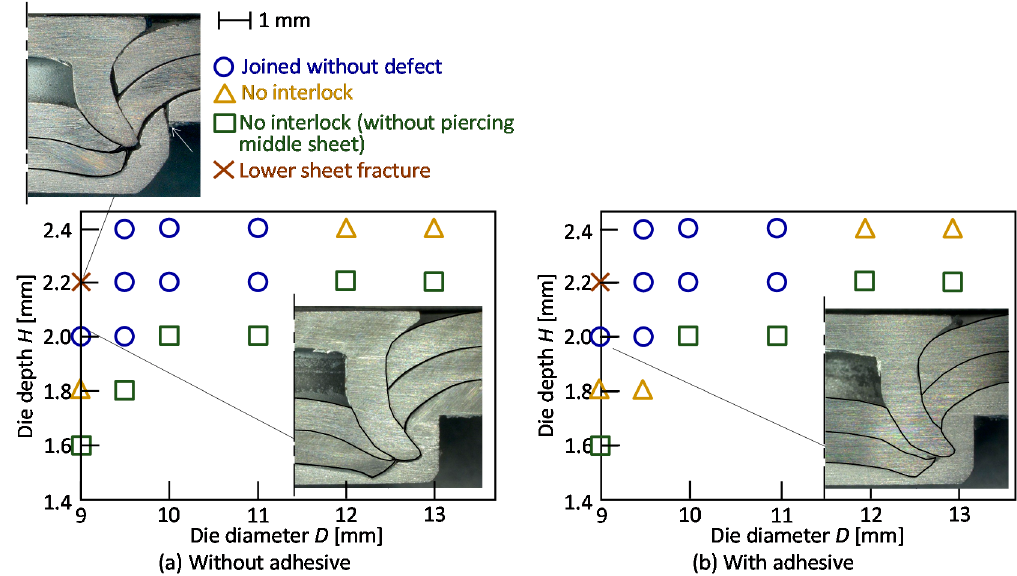
Figure 12. Joining ranges ( a ) without and ( b ) with adhesive for L = 6 mm.